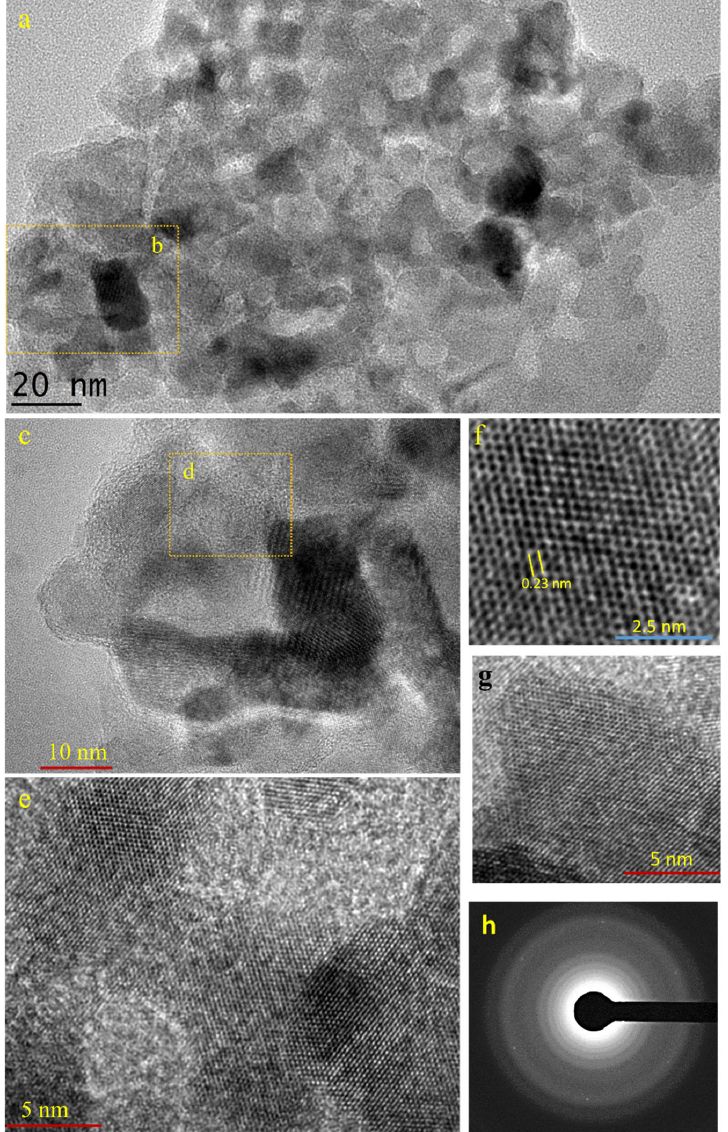
Figure 1. TEM image of 2D crystal of Pt. ( a ), Low ‐ resolution transmission microscopy image of 2D crystal of Pt. ( b ), The location for higher resolution analysis in ( c ). ( d ), The location for higher resolution analysis in ( e ). ( e – g ), The typical higher ‐ resolution transmission microscopy image of the 2D crystal of Pt sample. Image in ( f ) shows the lattice resemble graphene ‐ like structure. ( h ), Selected ‐ area electron diffraction (SAED) profile of 2D crystal of Pt on a carbon film ‐ coated copper grid. The halos come from the amorphous carbon film.